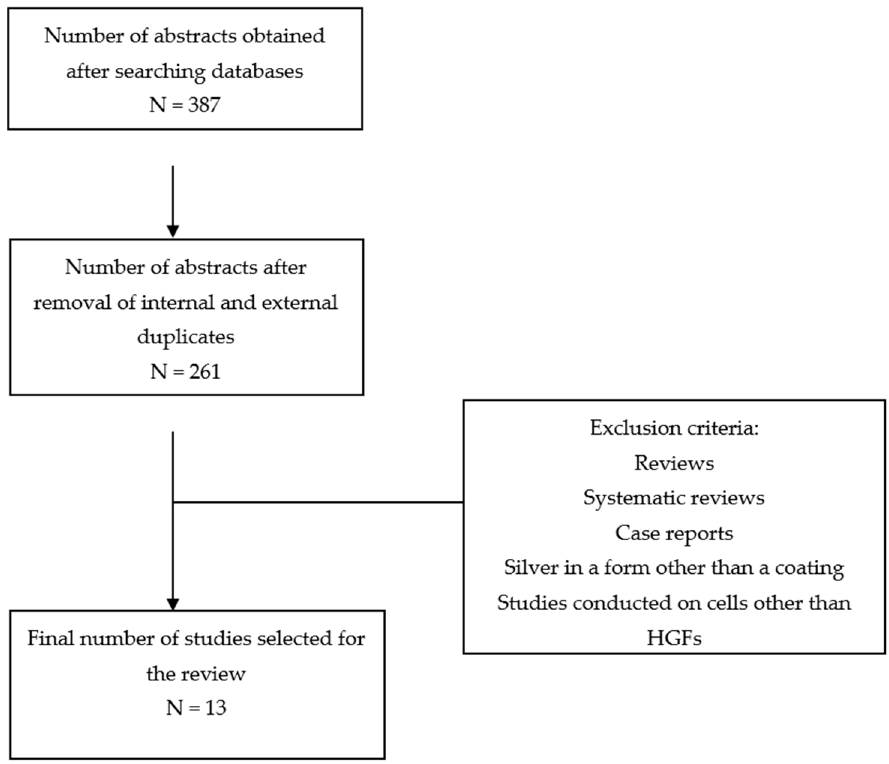
Chart 1. PRISMA flow diagram of the